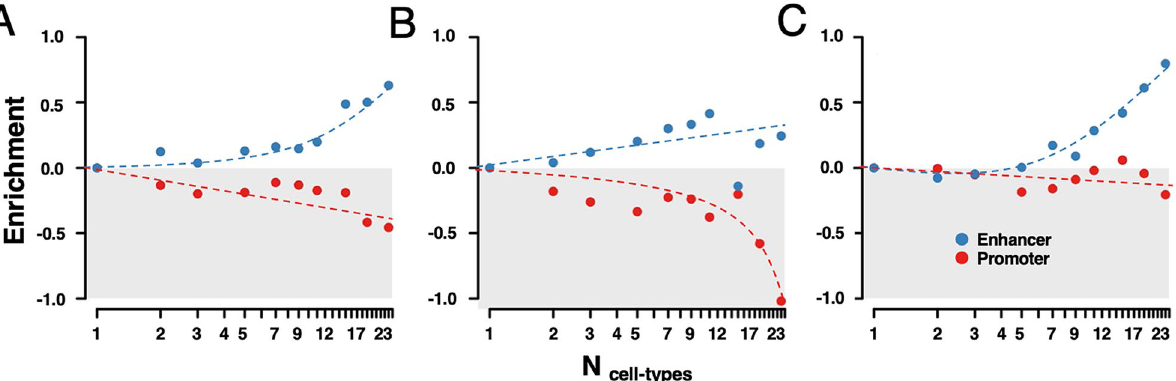
Figure 4. Characteristics of indispensable promoter/enhancer-binding transcription factors (TF) in cell-type specific regulatory networks. Randomly sampling sets of indispensable promoter and enhancer-binding TFs we found that enhancer-binding TFs that were indispensable for an increasing number of cell-type networks were ( A ) enriched with disease-causing genes, ( B ) cancer genes and ( C ) signaling functions. In turn, we found the opposite, when we considered indispensable promoter-binding TFs.